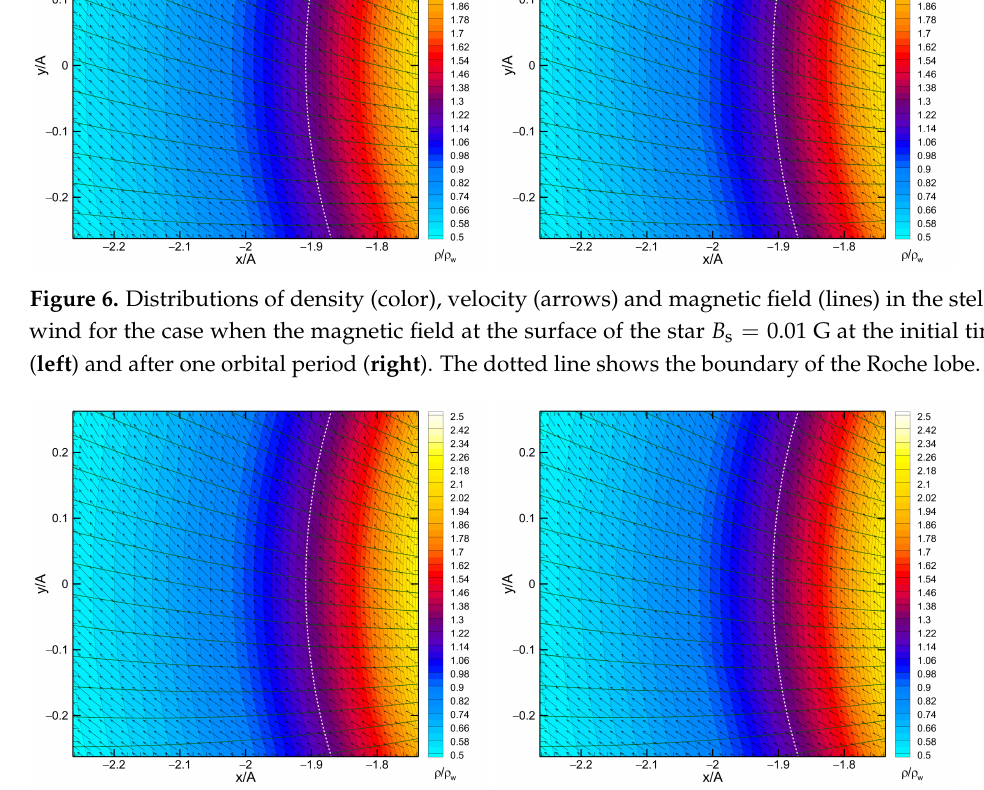
Figure 7. The same as in Figure 6, but for the case, when the magnetic field at the stellar surface B s = 0.5